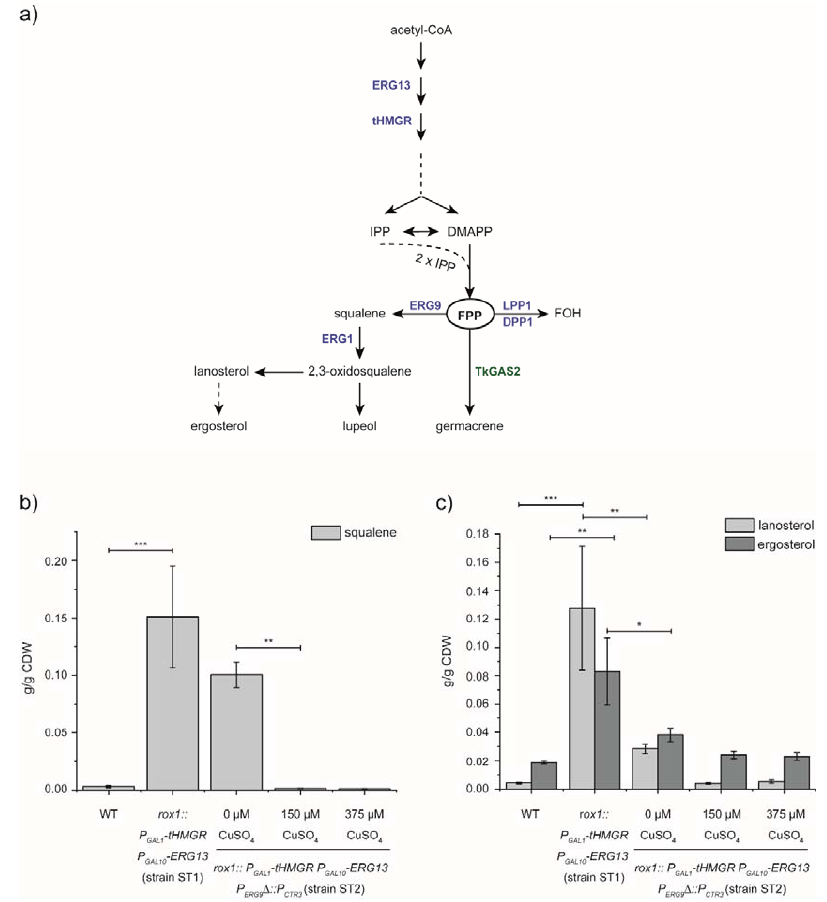
Figure 1. Redirection of MVA-pathway flux. ( a ) Schematic representation of the MVA-pathway leading to FPP ‐ synthesis and downstream metabolites. Dashed arrows represent multiple enzymatic steps. Yeast enzymes are indicated in blue. T. koksaghyz ‐ derived enzyme TkGAS2 is indicated in green. HMGS, 3 ‐ hydroxy ‐ 3 ‐ methylglutaryl ‐ coenzyme A (HMG ‐ CoA) synthase; HMGR, 3 ‐ hydroxy ‐ 3 ‐ methylglutaryl ‐ coenzyme A (HMG ‐ CoA) reductase; IPP, isopentenyl diphosphate; DMAPP, dimethylallyl diphosphate; FPP, farnesyl diphosphate; FOH, farnesol; LPP1, lipid phosphate phosphatase 1; DPP1, diacylglycerol pyrophosphate phosphatase 1; TkGAS2, T. koksaghyz germacrene-A synthase 2; ERG9, squalene synthase; ERG1, squalene epoxidase. ( b ) Yeast strain ST1 carrying